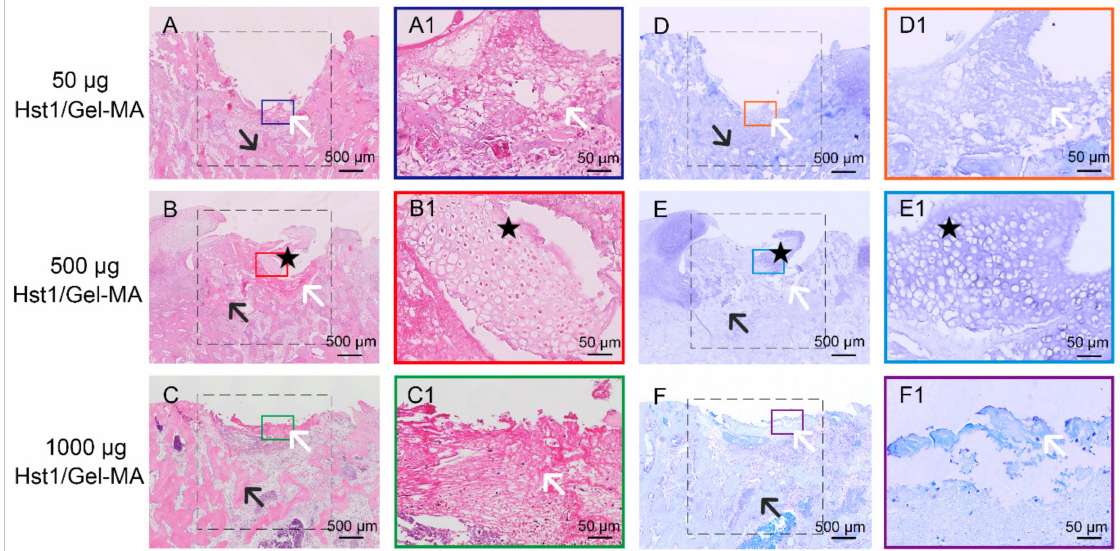
Figure 1. Light micrographs of H&E-stained ( A – C ) and toluidine blue-stained ( D – F ) tissue sections of rabbit condyles with critical-size (3 mm in diameter and 3 mm in depth) osteochondral defects that were treated using Gel-MA with 3 different doses of Hst1 ( A , D ) 50, ( B , E ) 500, and ( C , F ) 1000 µ g per defect. The tissues were retrieved at 2 weeks postoperation and then subjected to histologic processing and sectioning. The dotted square area indicates the original defect area. Black star: immature cartilage cells; black arrow: newly formed subchondral bone; white arrow: Hst1/Gel-MA materials. Scale bar = 500 µ m in A – F ; Scale bar = 50 µ m in A1 – F1